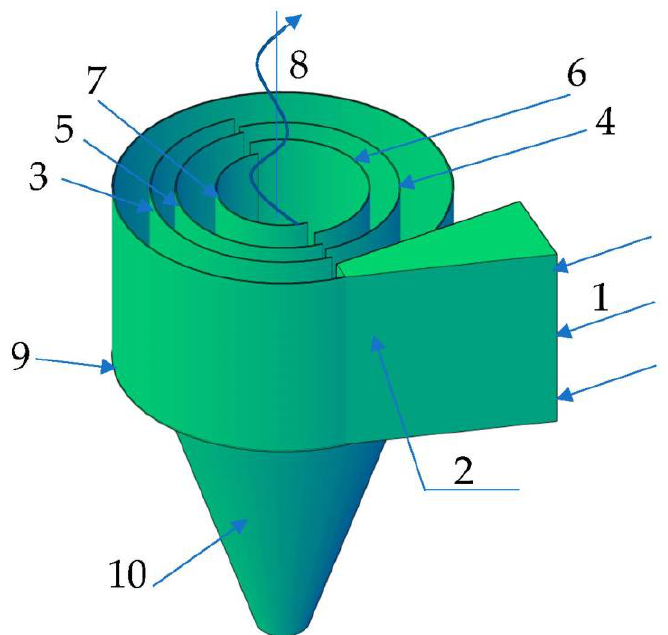
Figure 1. The basic diagram of the six-channel cyclone’s structure: 1—air flow inlet, 2—diffuser, 3–7—curvilinear semi-rings of different radii, 8—air flow outlet, 9—six-channel cyclone’s bottom with segmented circular spaces, 10 — six- channel cyclone’s conical hopper.